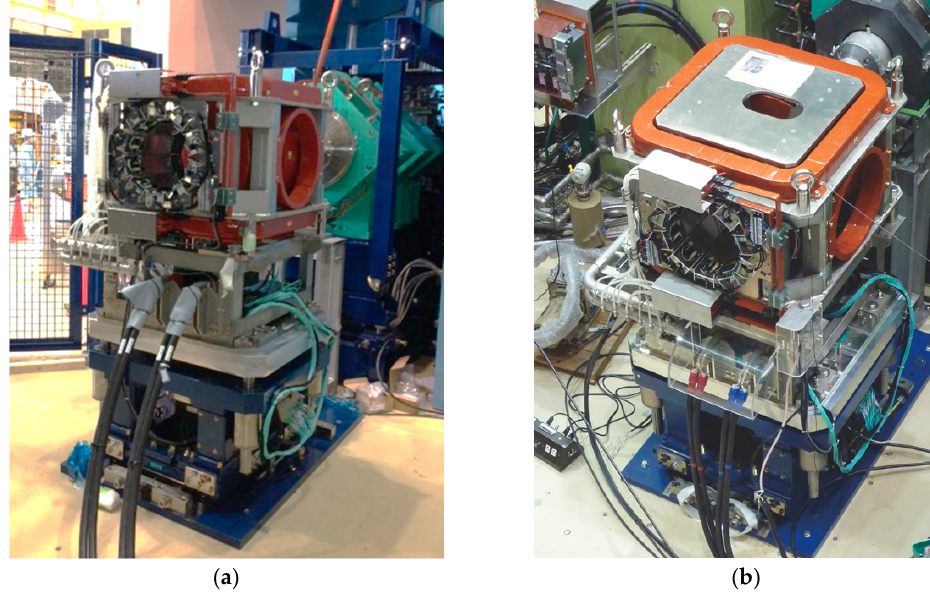
Figure 13. Twin general-purpose µSR spectrometers: ( a ) S1-Advanced Research Targeted Experimental Muon Instrument at S-line (S1-ARTEMIS); and ( b ) the D1 instrument. Each spectrometer includes 40 Kalliope units for positron/electron detection that cover 21.2% of the solid angle. Magnets are equipped to apply magnetic fields of up to 0.4 T and 14 mT in the horizontal and vertical directions, respectively, and xyz stray-field compensation coils are employed to produce a field of 0 T at the sample position.